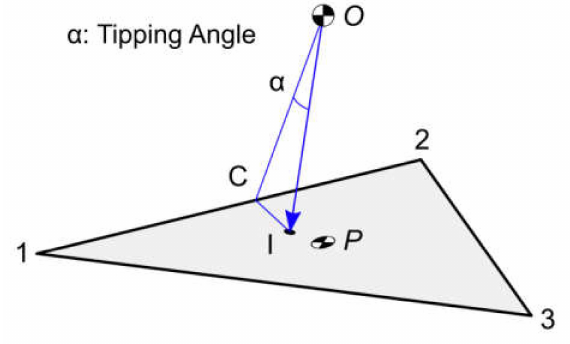
Figure 5. Tipping angle